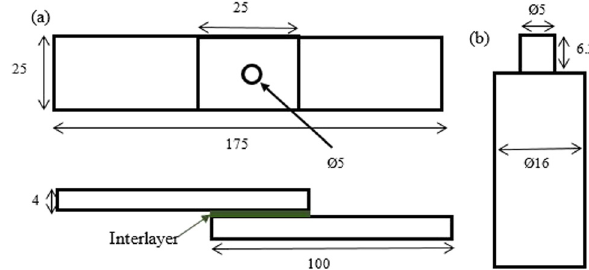
Table 1: Two - level 2 k full factorial design: experiments de fi ned